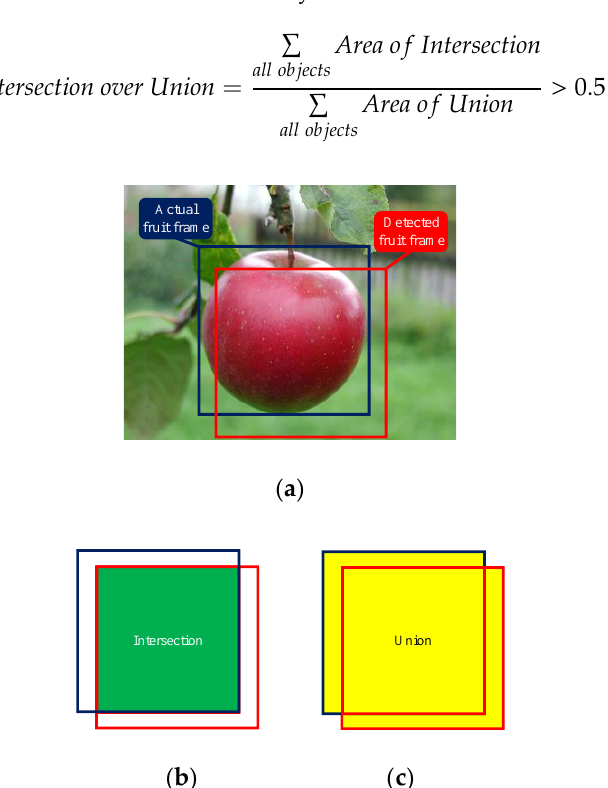
Figure 1. Intersection over Union for fruits detection. ( a ) Ground-truth fruit bounding box and detected fruit bounding box; ( b ) Intersection; ( c ) Union.